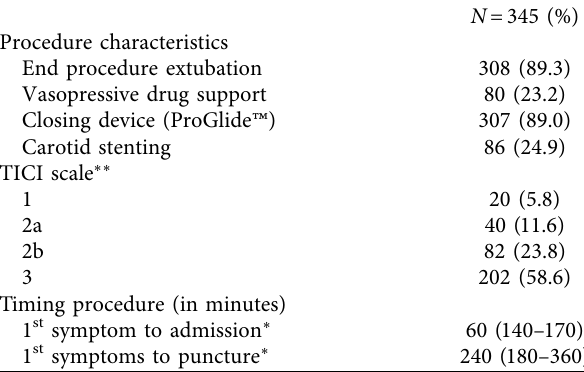
Table 2: MT procedures